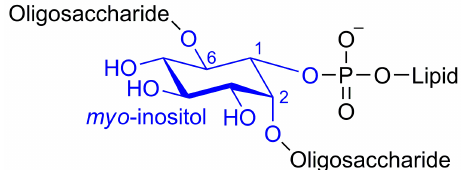
Figure 1. Core structure of a typical glycosylphosphatidylinositol (GPI). The inositol may be glycosylated at O -2, at O -6, or at both positions. The lipid is generally a diacylglycerol, but in glycosylinositol phosphorylceramides (GIPCs) the lipid is a ceramide.